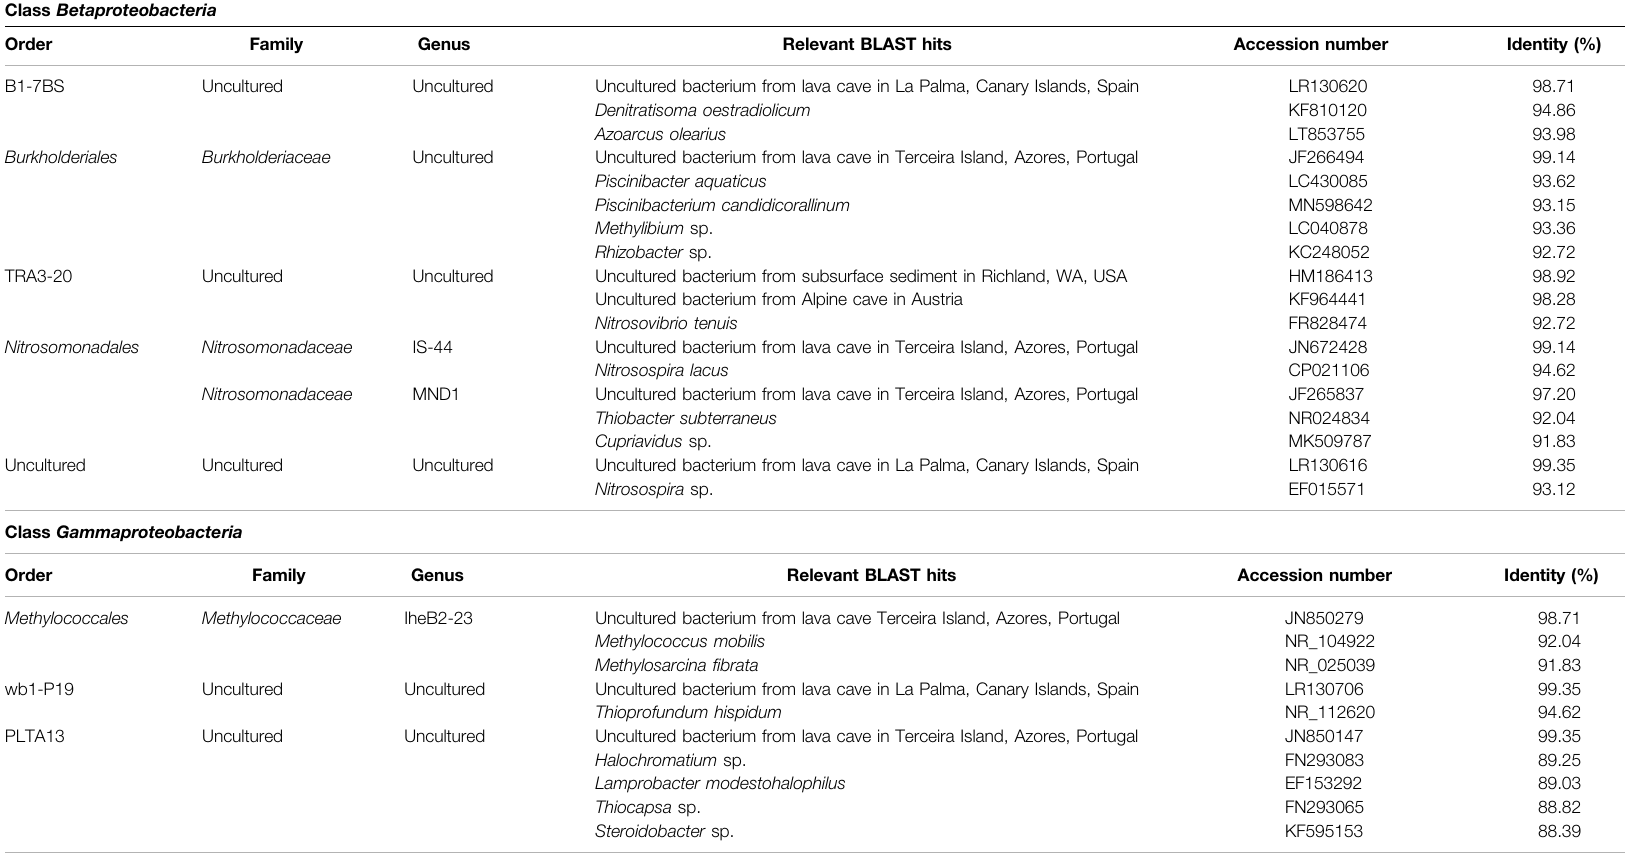
TABLE 4 | Taxonomic af fi liation of the sequences of Betaproteobacteria and Gammaproteobacteria , based on 16S rRNA amplicon sequence